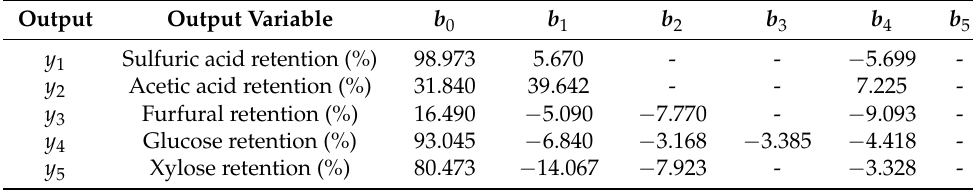
Table 4. The coefficient list of the identified models.